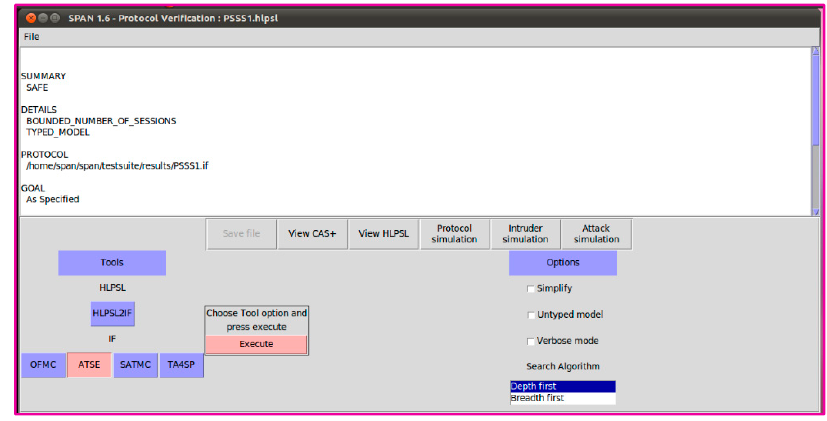
Figure A1. OFMC simulation results.